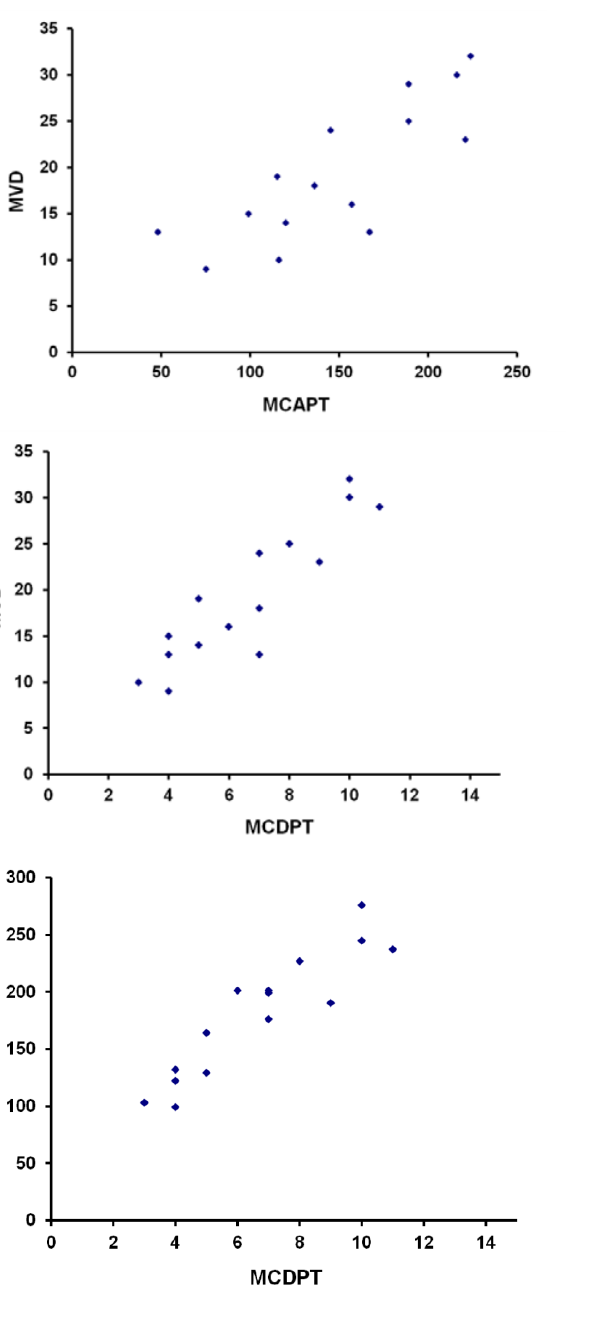
Figure 2. Each blue dot represents the linear correlation between MCDPT and MVD ( r = 0.82, p = 0.00), MCDPT and MCAPT ( r = 0.77, p = 0.01), MCDPT and EA ( r = 0.73, p = 0.01), MCAPT and MVD ( r = 0.68, p = 0.02), MCAPT and EA ( r = 0.71, p = 0.02), between MVD and EA ( r = 0.78, p =